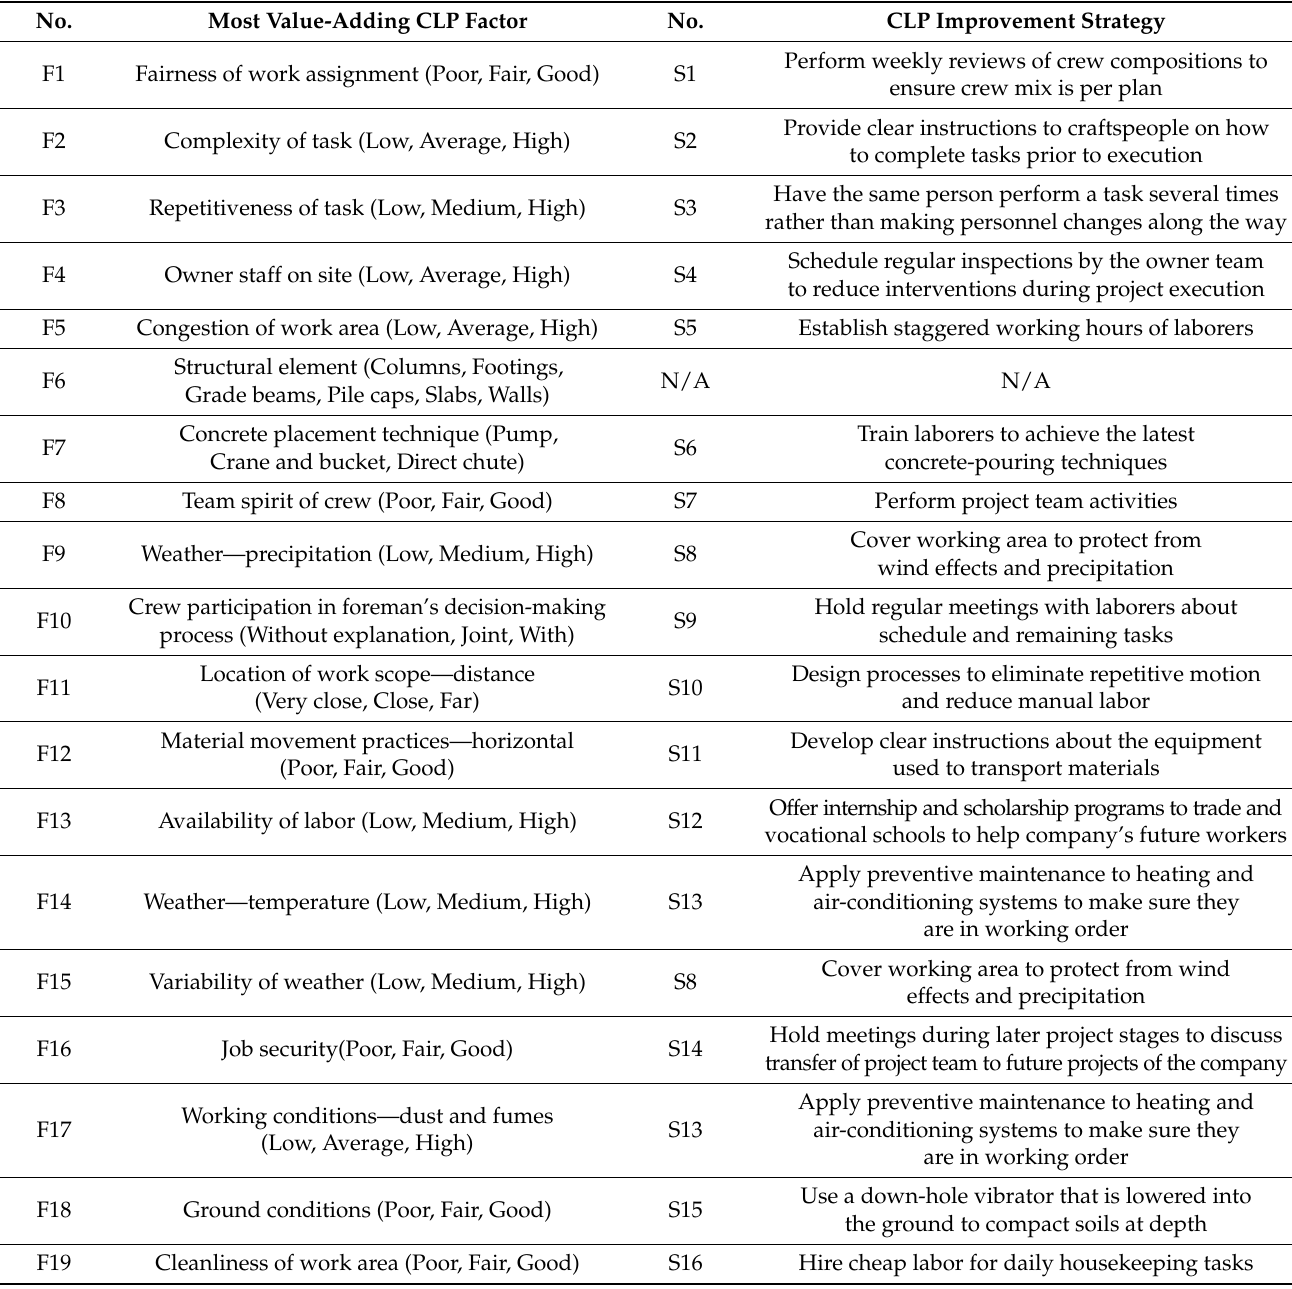
Table 1. The most value-adding CLP factors and their corresponding improvement